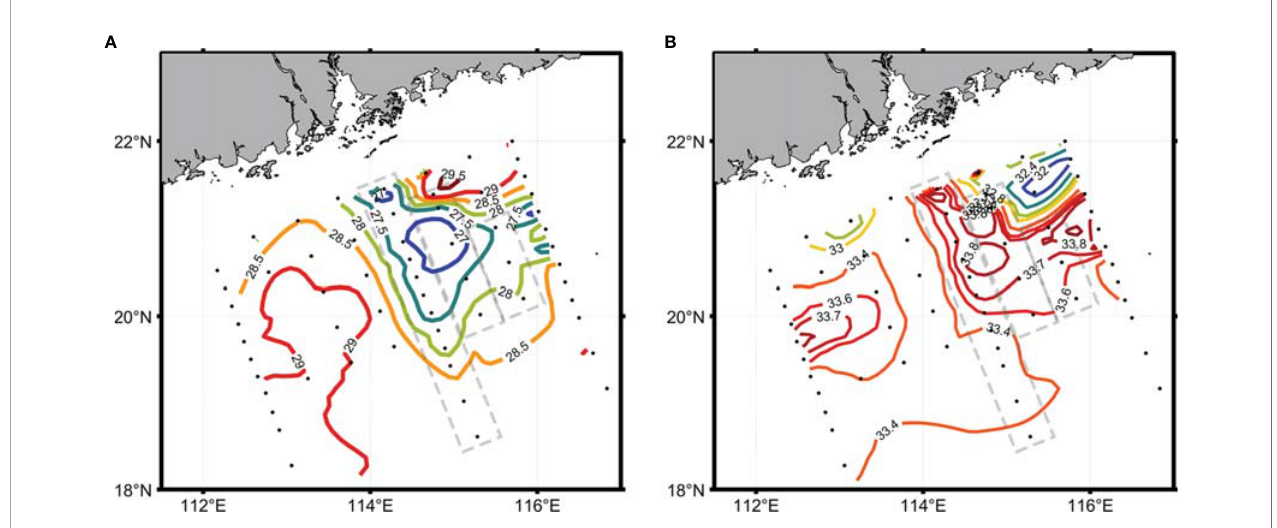
FIGURE 2 | Sea surface temperature (SST, °C) (A) and sea surface salinity (SSS) (B) in the study area. The gray dashed boxes are the stations sampled after the